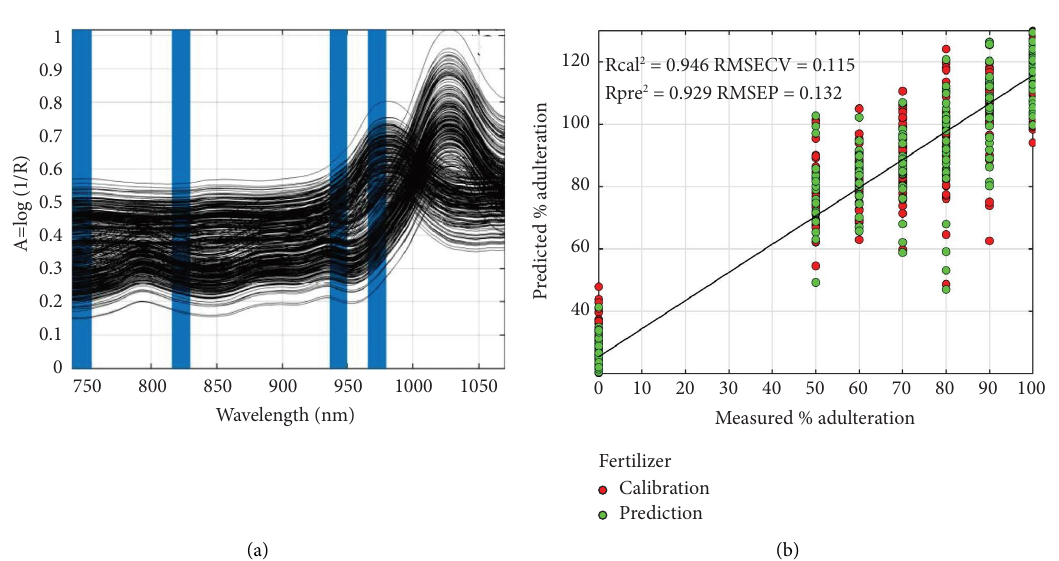
Figure 9: Si-PLS spectra selection (a) and plot (b) of NIR estimation and measured